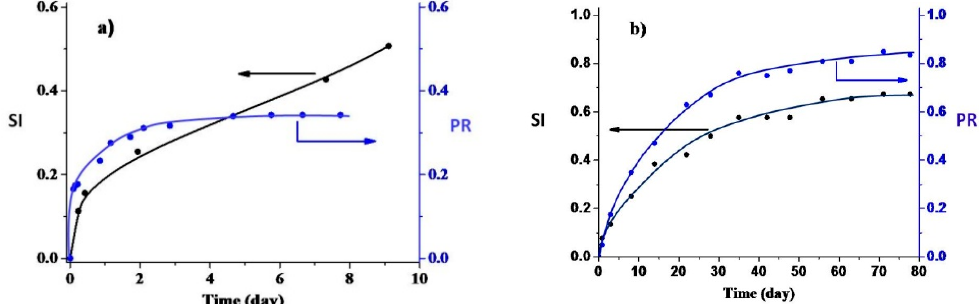
Figure 9. Time dependences of the swelling index (SI, black symbols, measurement errors are 5–7% ) and of the part of radicals, localized in pores (PR, blue symbols, measurement errors are 10–12% ) for TEMPOL in PDL 02 film ( a ) and for TEMPONE in PDL 04 film ( b ): the lines are not the results of fitting.